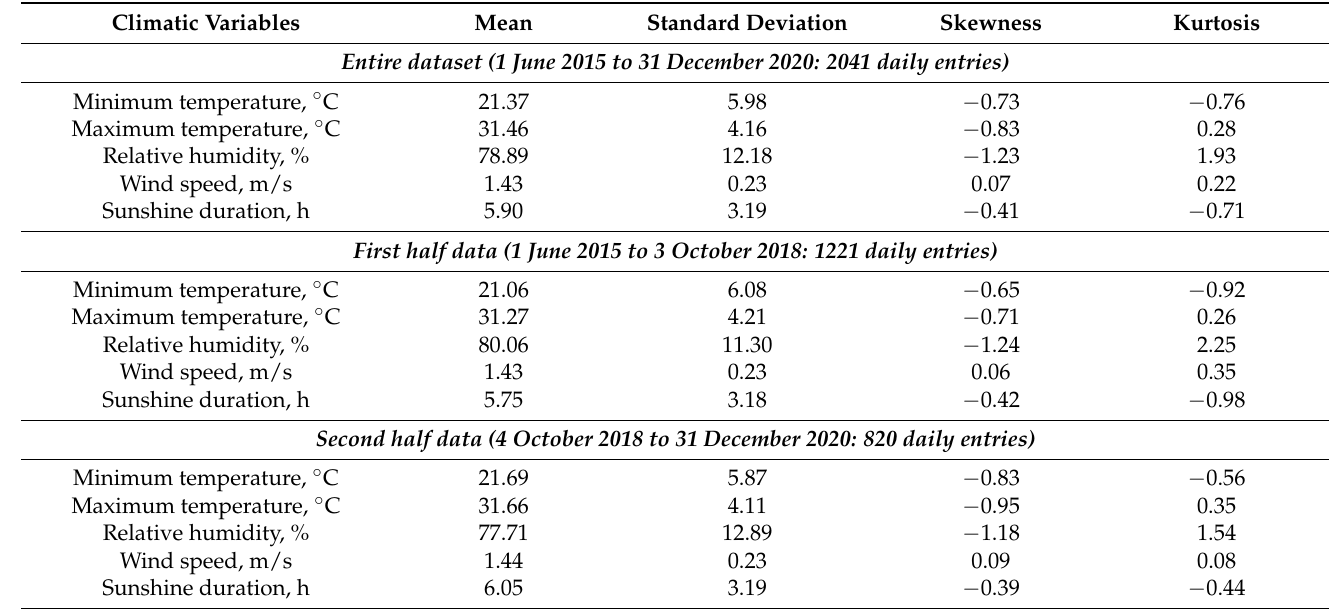
Table 2. Descriptive statistics of the entire, first half, and the second half of the weather data for the test station (Ishurdi